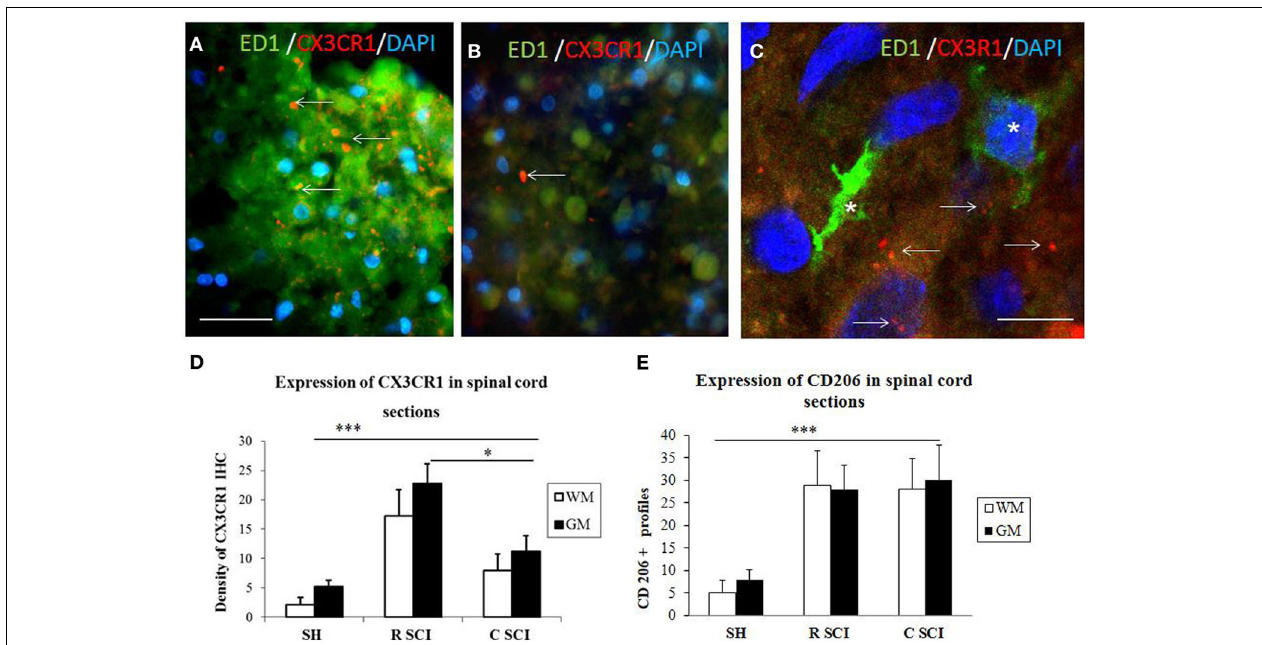
of CX3CR1was significantly higher when comparing Sham (SH) sections with sections from injured spinal cord (SCI), sections from rostral (R SCI) compared with caudal (C SCI) segment within WM/GM. (E) CD206 + profiles significaly increased when compared Sham (SH) sections with sections from injured spinal cord (SCI), not between R SCI and C SCI sections. Data are presented as mean ± s.e.m., ∗ P < 0 . 05, ∗∗∗ P < 0 . 001 for sham vs. SCI, or rostral to caudal after SCI for group comparison W/G matter (ANOVA) followed by Tukey-Kramer test. Scale bars (A,B) = 50 μ m, (C) = 20 μ m.